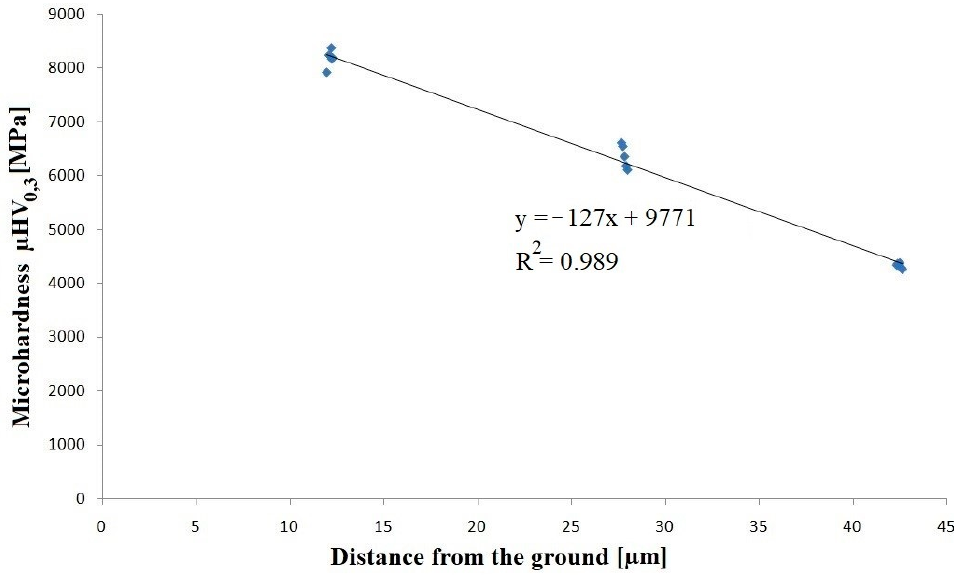
Figure 1. Influence of distance from substrate on microhardness of oxide layer. All the determined microhardness values for the subsequent samples are presented in Table 5. Table 5. Influence of thermo-chemical treatment on value of microhardness of Al 2 O 3 layers Compound for Sample